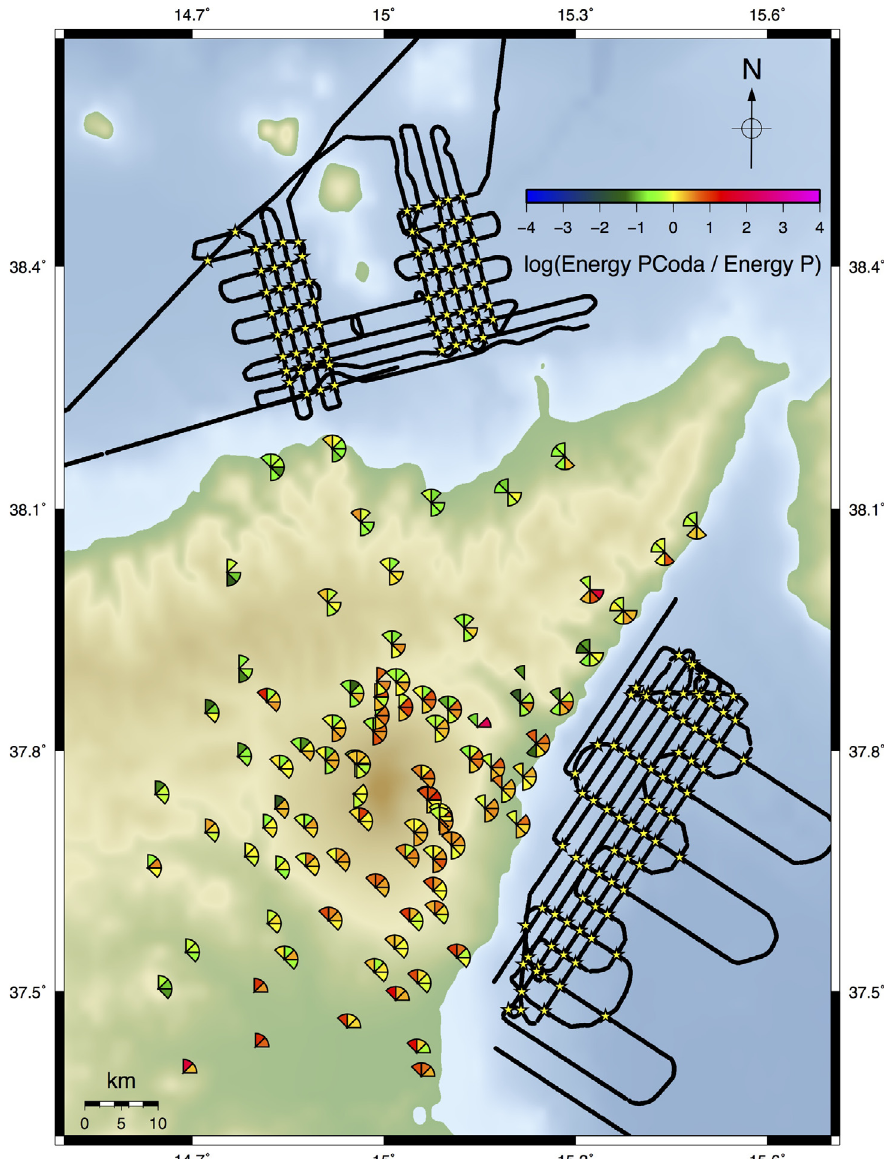
Figure 6. Energy ratio, depending on back azimuth. Each pie wedge uses at least five single values for averaging. Green and blue colors symbolize a low energy ratio (weak scattering), yellow and red sym- bolize high energy ratio